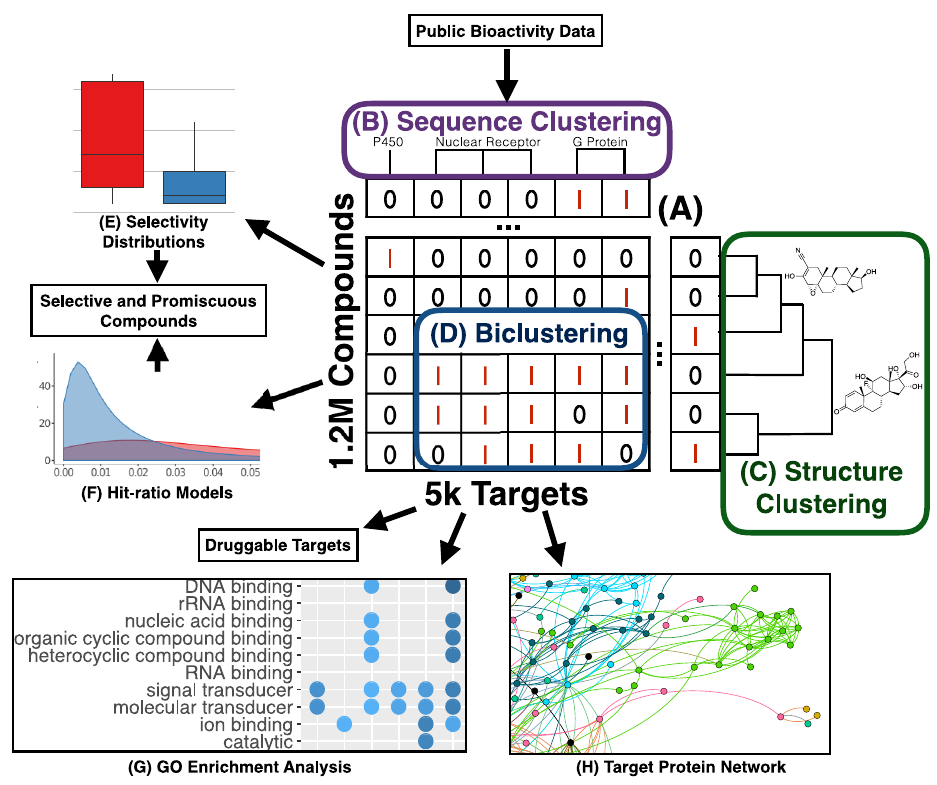
Fig 1. Bioactivity data mining strategy. Public bioactivitydata was first summarized in a compound-target bioactivitymatrix ( A ). Protein targets and small moleculeswere clustered by sequence( B ) and structure ( C ) respectively, and compound-target sets with shared bioactivity profileswere identifiedwith biclustering ( D ). For small molecules,the distributionsof ( E ) target selectivity (the number of active targets) and ( F ) hit ratio (the fraction of screenedtargets that are active) were quantified.For protein targets, enrichedGO (Gene Ontology) terms ( G ) among proteinswith common bioactivity were identified,and a network ( H ) was constructed which connects target proteinswith similar bioactivity profiles. These analyseshighlightseveral interesting bioactivity patterns, identify promiscuous and selective compounds, and identify druggableprotein targets and protein